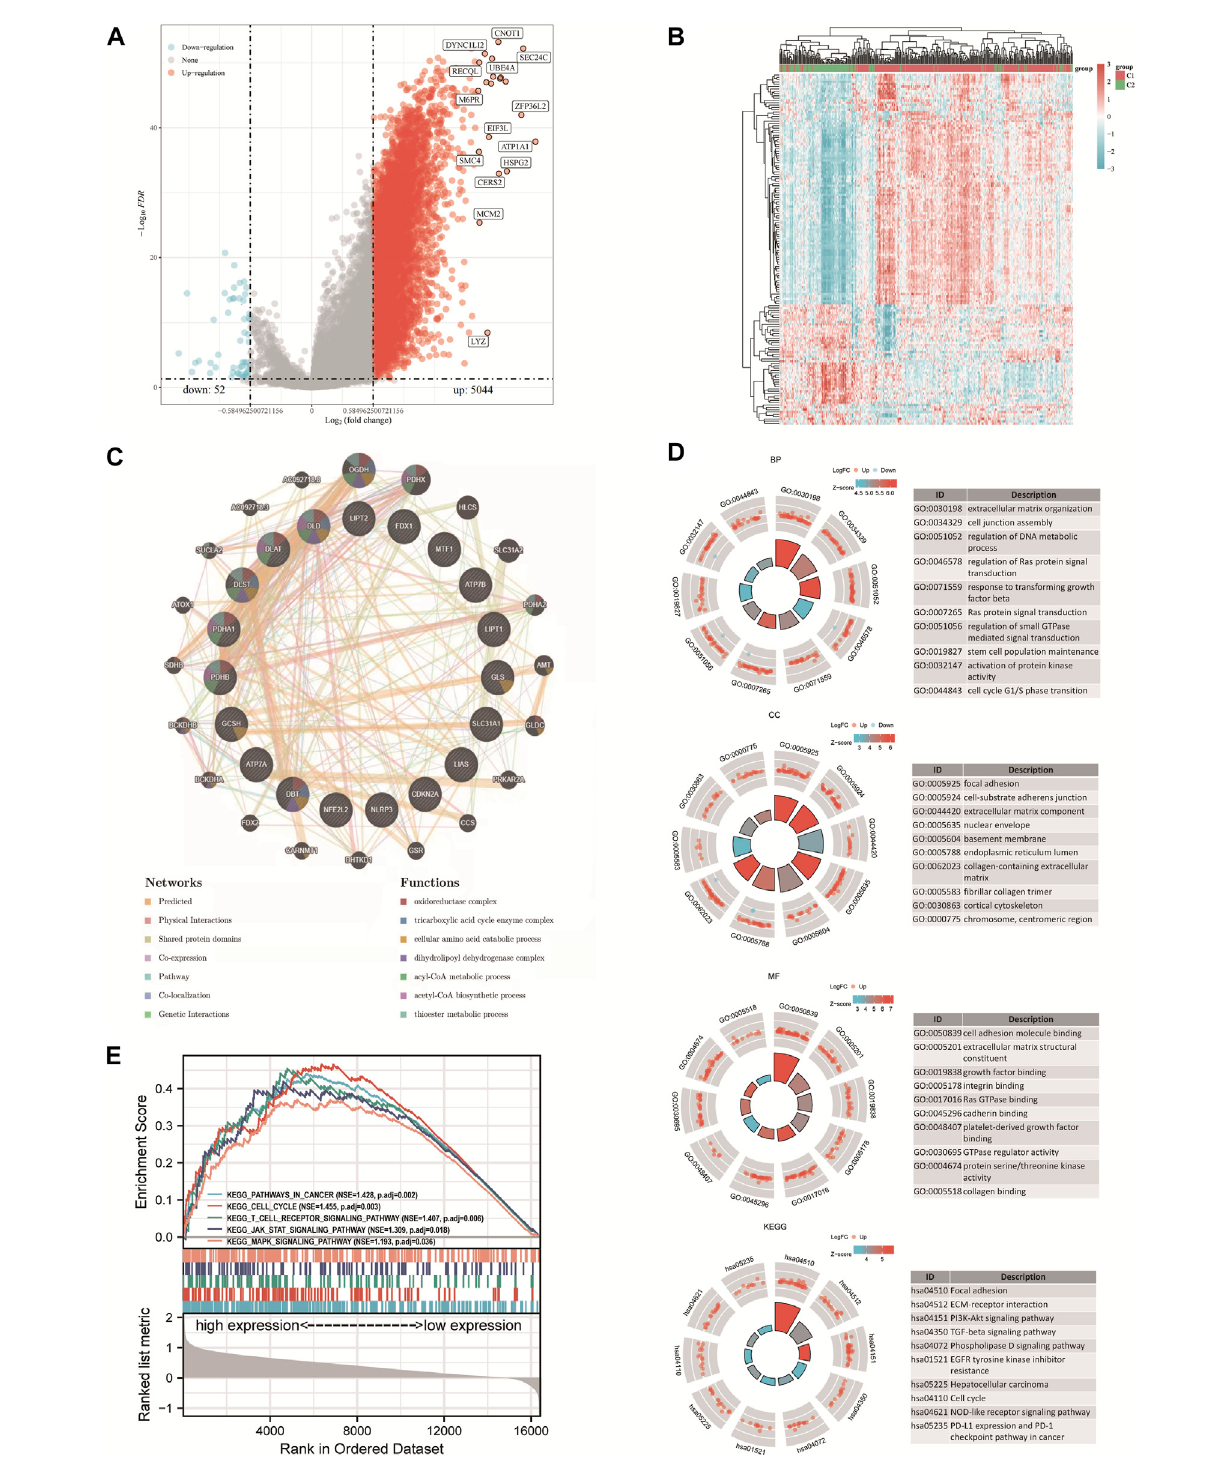
FIGURE 3 DEGsandfunctionalenrichmentanalysis. (A) DEGs ’ volcanoplotbetweenC1andC2subtypes. (B) DEGs ’ heatmapbetweenC1andC2subtypes. (C) Gene Interaction Network. (D) Enriched item in gene ontology (GO) analysis and Kyoto Encyclopedia of Genes and Genomes analysis (KEGG). (E) Enrichment plots from GSEA. BP, biological process; CC, cellular composition; MF, molecular